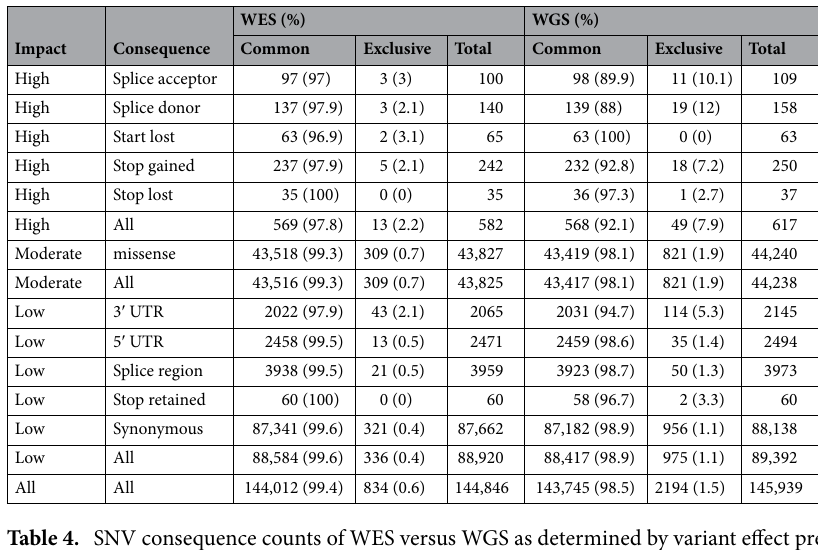
Table 4. SNV consequence counts of WES versus WGS as determined by variant effect predictor.